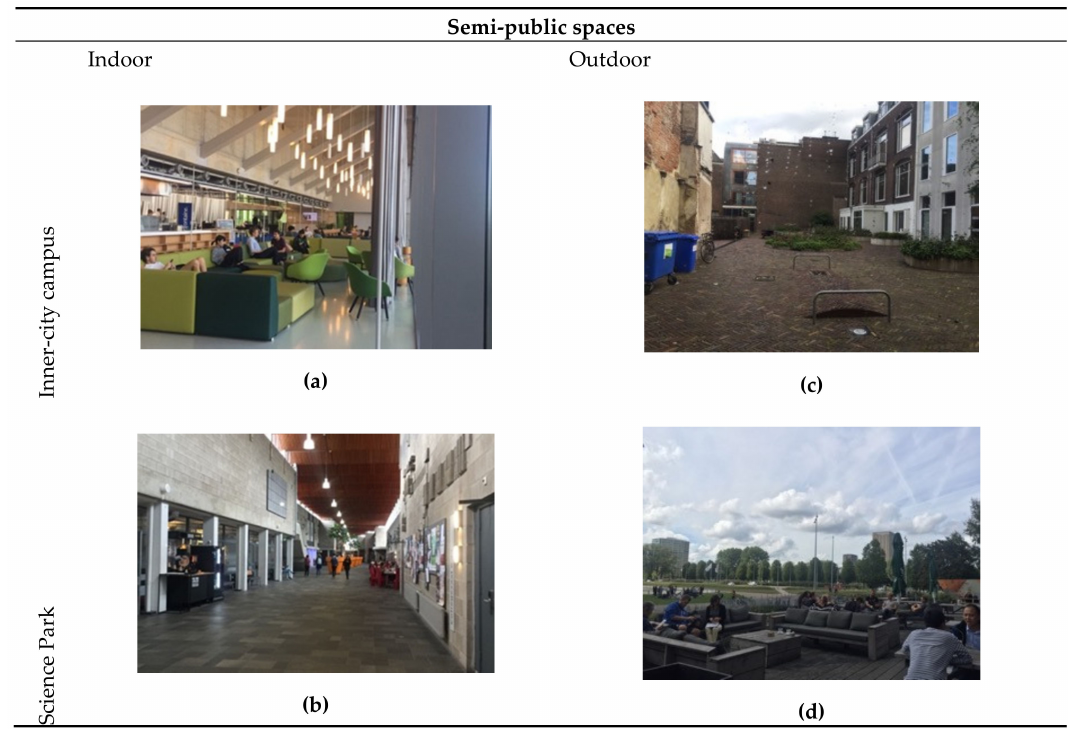
Figure 16. Semi-public spaces at inner-city campuses and SPs: ( a ) the ‘brug’ located at the RI; ( b ) Internal corridor at the USP Educatorium; ( c ) Backyards of buildings at inner-city Utrecht; ( d ) ASP sport centre bar /